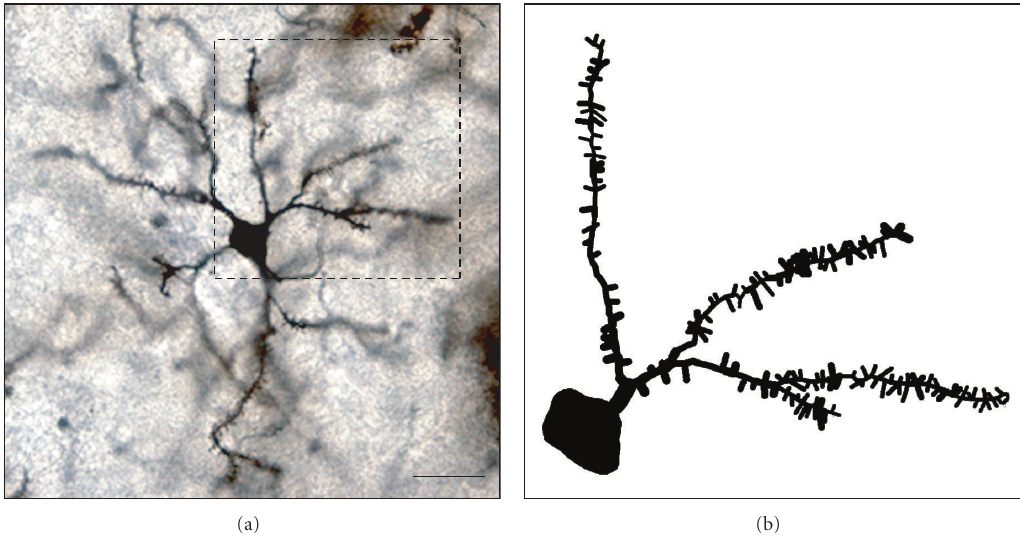
Figure 2: Golgi stained MSNs. Photomicrograph of a representative Golgi-impregnated medium spiny neuron with high-magnification inserts of a primary dendritic branch and fifth-order dendritic branch (a) and corresponding neurolucida tracing (b). Scale bar = 10 μ